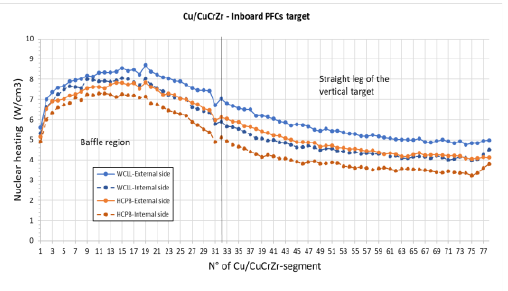
Figure 38. Inner poloidal profiles of the nuclear heating (W/cm 3 ) on Cu/CuCrZr components, com-